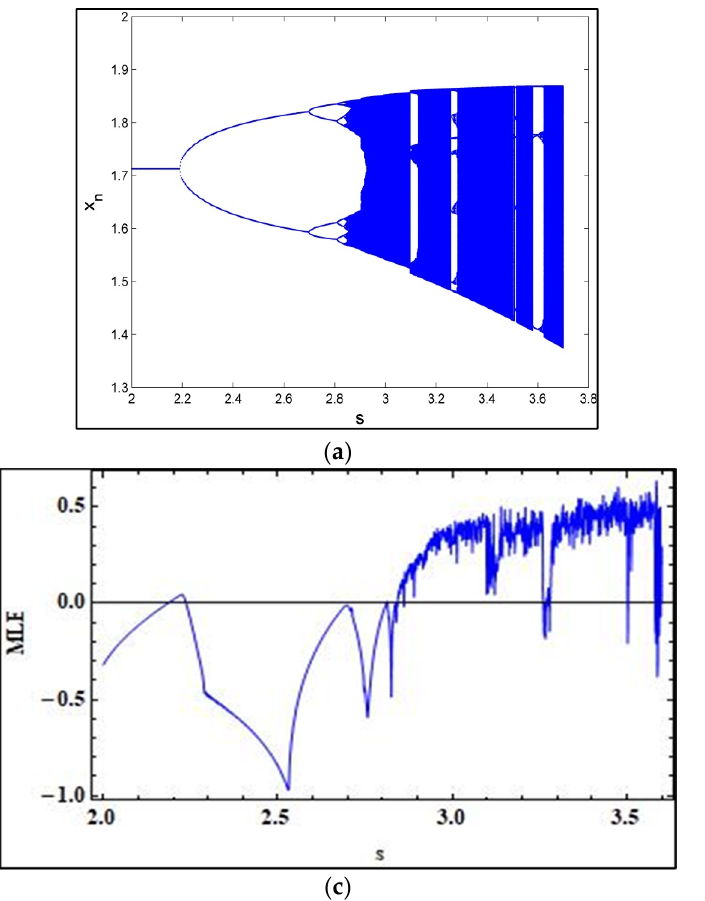
Figure 3. Bifurcation diagrams and MLE for system (4) with parameters (cid:1854) = 3.3, (cid:1853) = 0.8, (cid:1870) = 1.3, ℎ = 2.7, (cid:1863) = 1.8 , (cid:1871) ∈ [2,3] , and ((cid:1876) (cid:2868) , (cid:1877) (cid:2868) ) = (1.74693,0.647013) : ( a ) period-doubling bifurcation for (cid:1876) (cid:3041) , ( b ) period-doubling bifurcation for (cid:1877) (cid:3041) , and ( c ) MLE. Furthermore, if (cid:1871) = 2.4, then the equilibrium point ((cid:1876) ∗ , (cid:1877) ∗ ) = (1.712924751,0.6344165743) loses its stability and undergoes periodic doubling (see Figure 4).